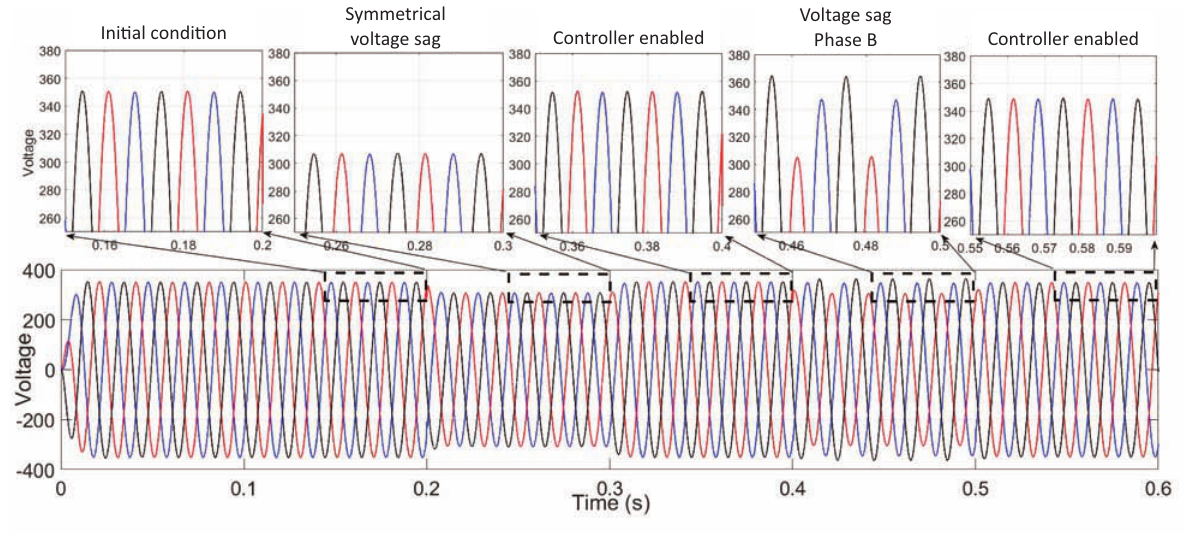
Fig. 9. VVooltage after using the filter with symmetrical and asymmetrical voltage